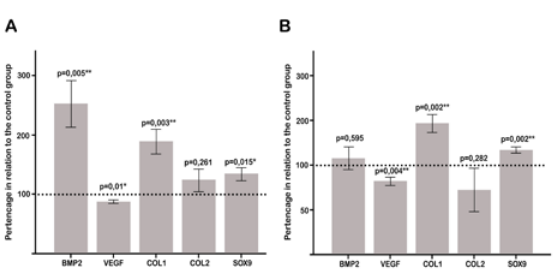
Figure 3. Regulation of fibrochondrocyte gene expression by biomechanical loading; (A) 4 hours, (B) 24 hours.